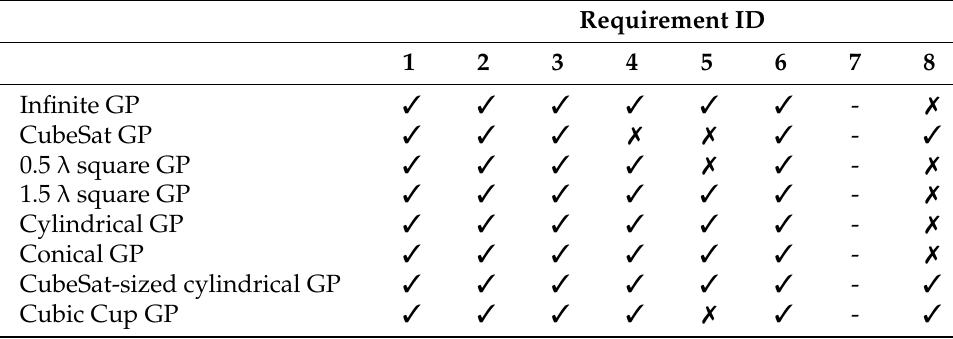
Table 8. Requirements compliance for the GP shapes simulated along Section